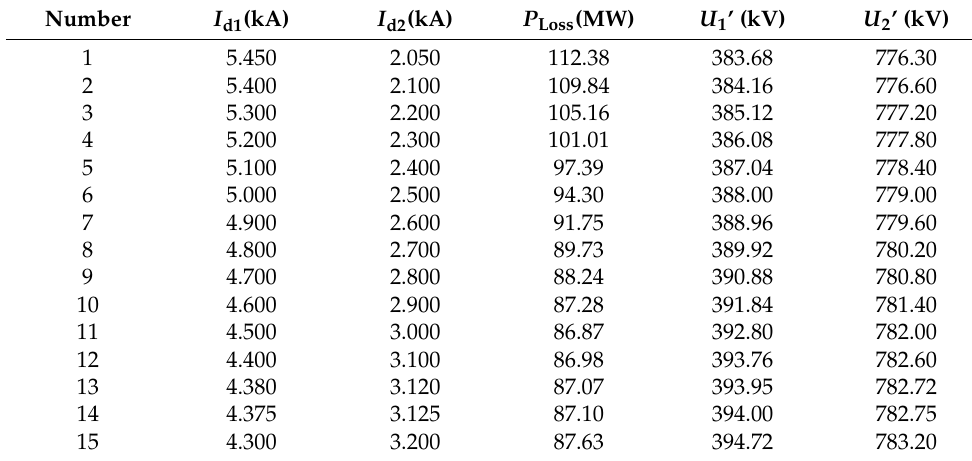
Table 1. Comparison of power loss and voltage variation.